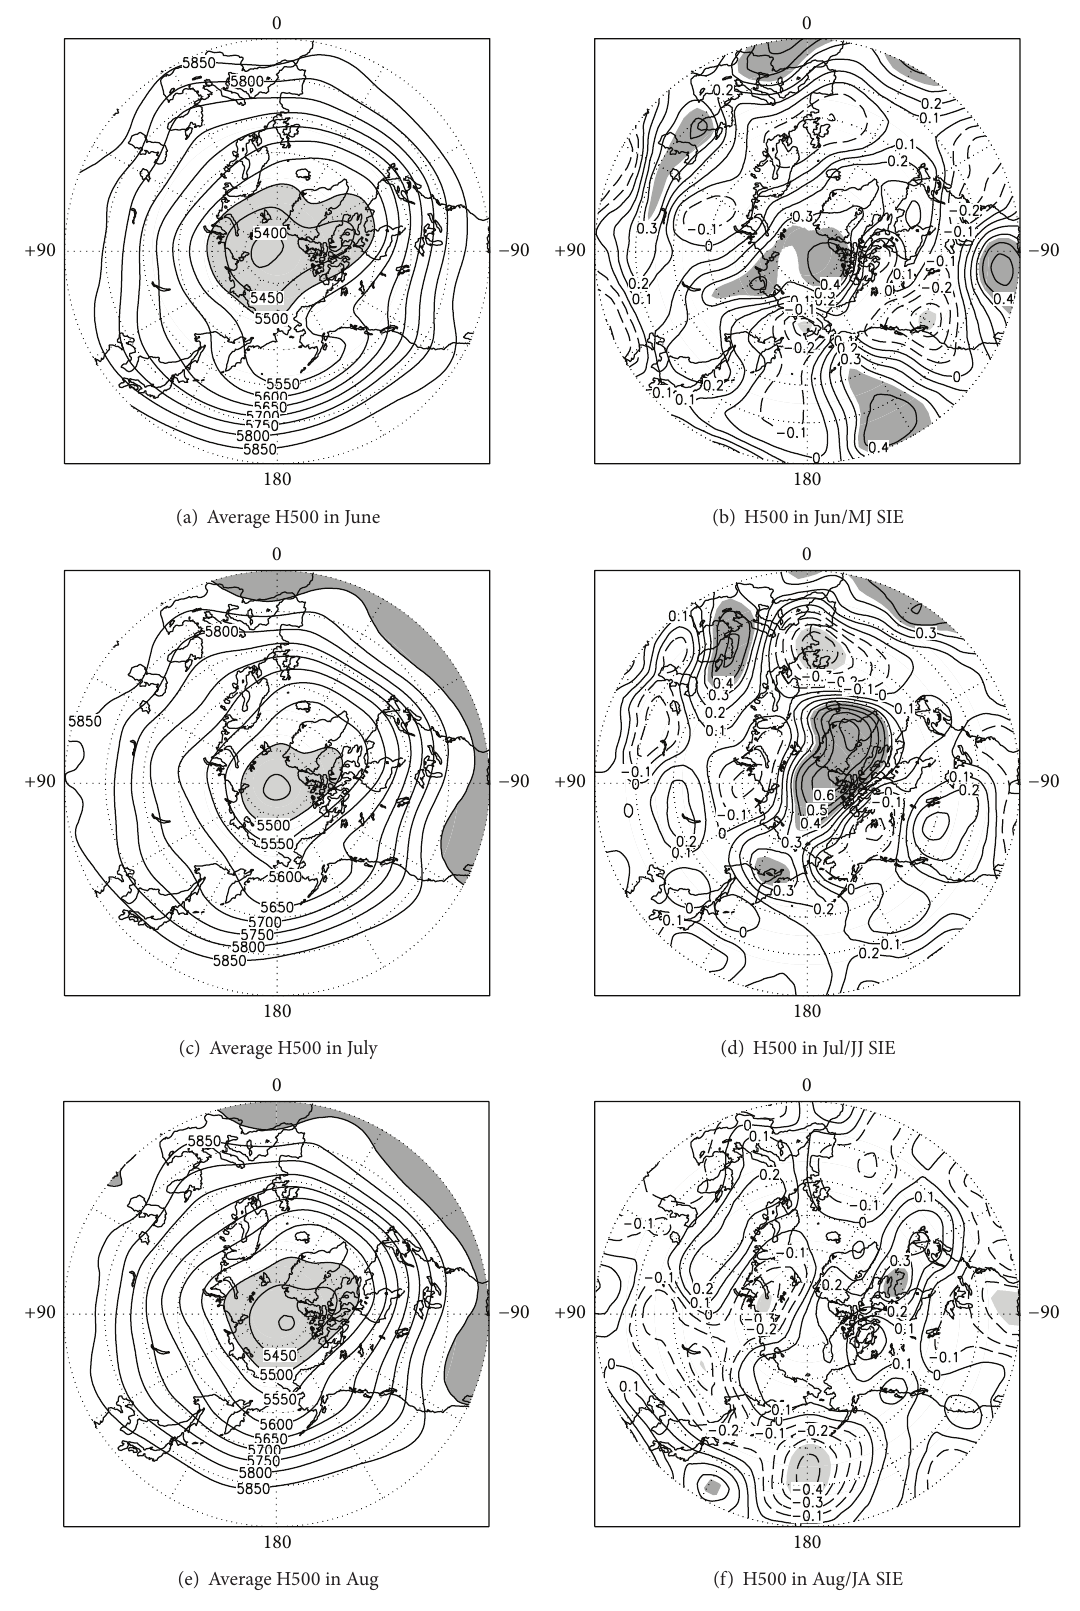
Figure 5: As in Figure 3 but for monthly 500 hPa